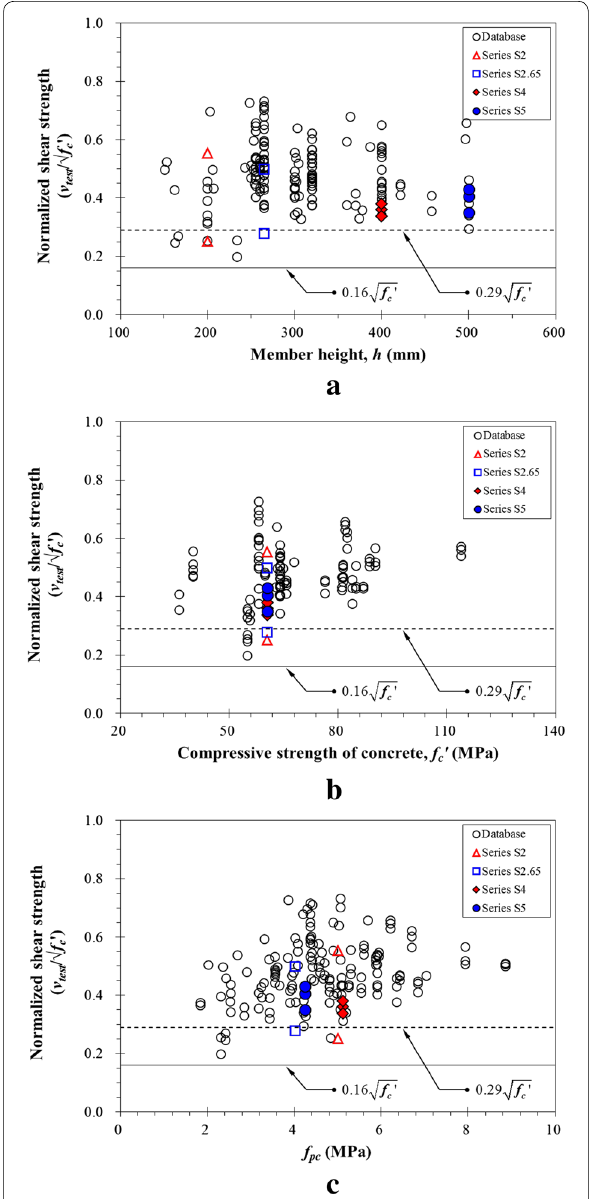
Fig. 10 Effect of key variables on the web‑shear capacity of PHCS. a Member height, b concrete compressive strength, c prestress introduced in centroid of section.